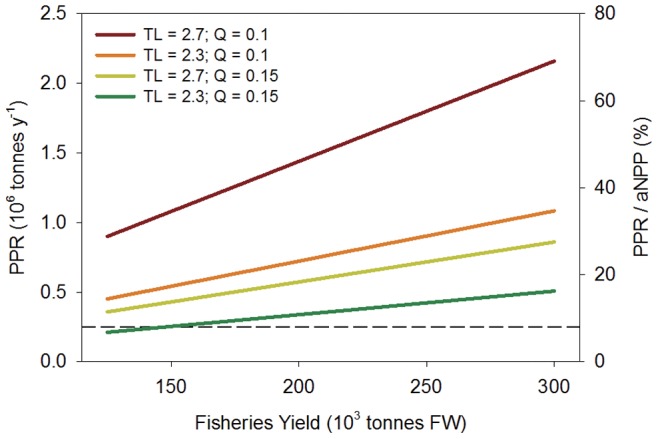
The amount of primary production required to support the Tonle Sap fishery (PPR) over a range of potential fisheries yields (see text for explanation).Each line is a different scenario of carbon transfer through the food web and is a function of the average trophic level of the catch (TL) and trophic efficiency (Q). The right axis shows PPR as a percent of total aquatic net primary production (aNPP). The dashed line indicates the global weighted average for freshwater and marine fisheries (∼8%) [33].